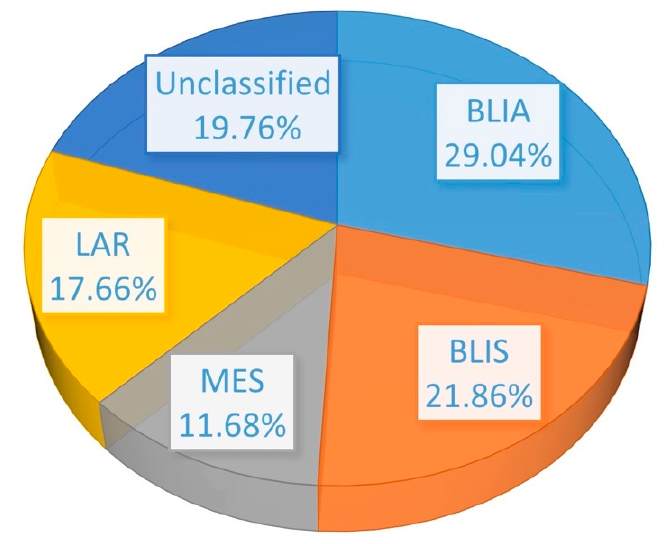
Figure 5. Pie chart showing the percentage of TNBC patients in the test set (334 cases) that were classified into four subtypes or unclassified.